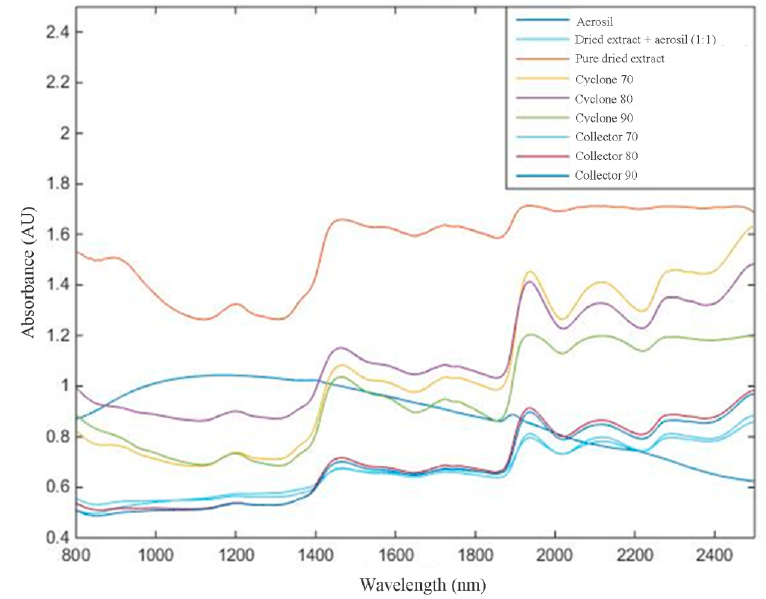
Figure 4. Near-infrared (NIR) spectral data obtained from 800 to 2500 nm with no mathematical treatment.